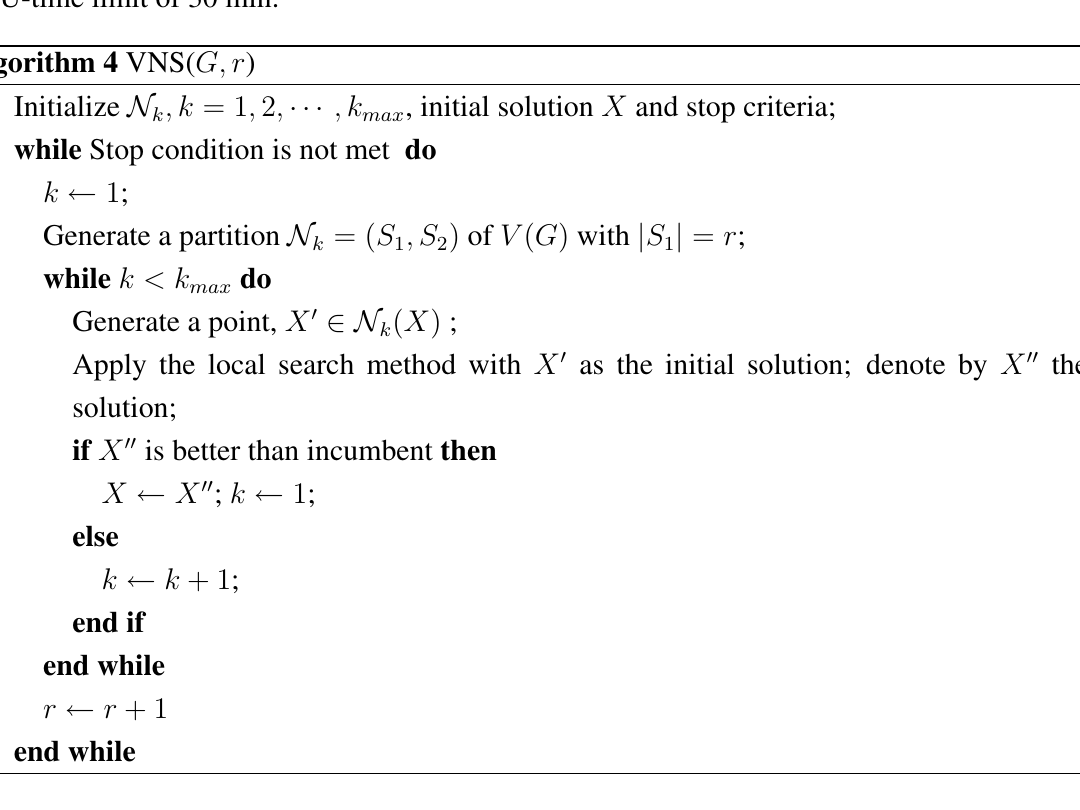
Table 3. Results for NewKLS FVS (LS, local search; FVS, feedback vertex set) and a CPU-time limit of 30 min for 15